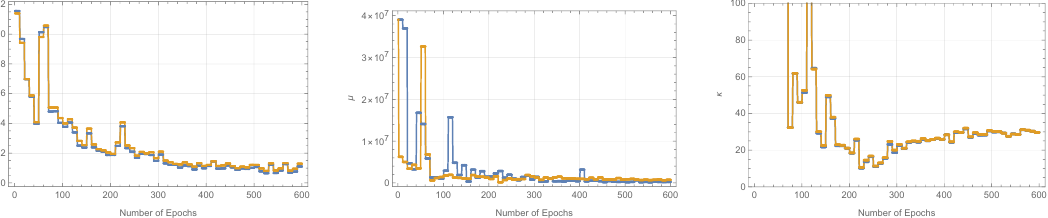
Figure 6 . Evolution of the measures during the training process for the quartic K3 surface (2.5). In this case, we have used a tanh activation function. The measures on the training set are depicted blue and on the test set are depicted yellow. The training is performed with a loss function that includes all three